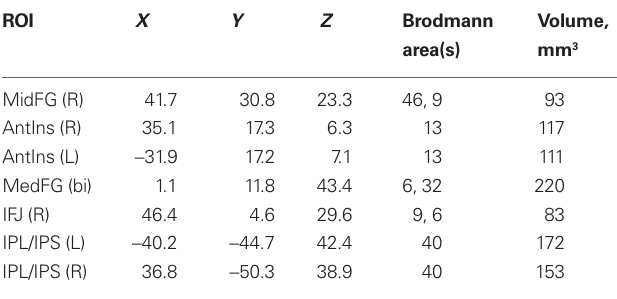
Table 3 | regions of interest locations and